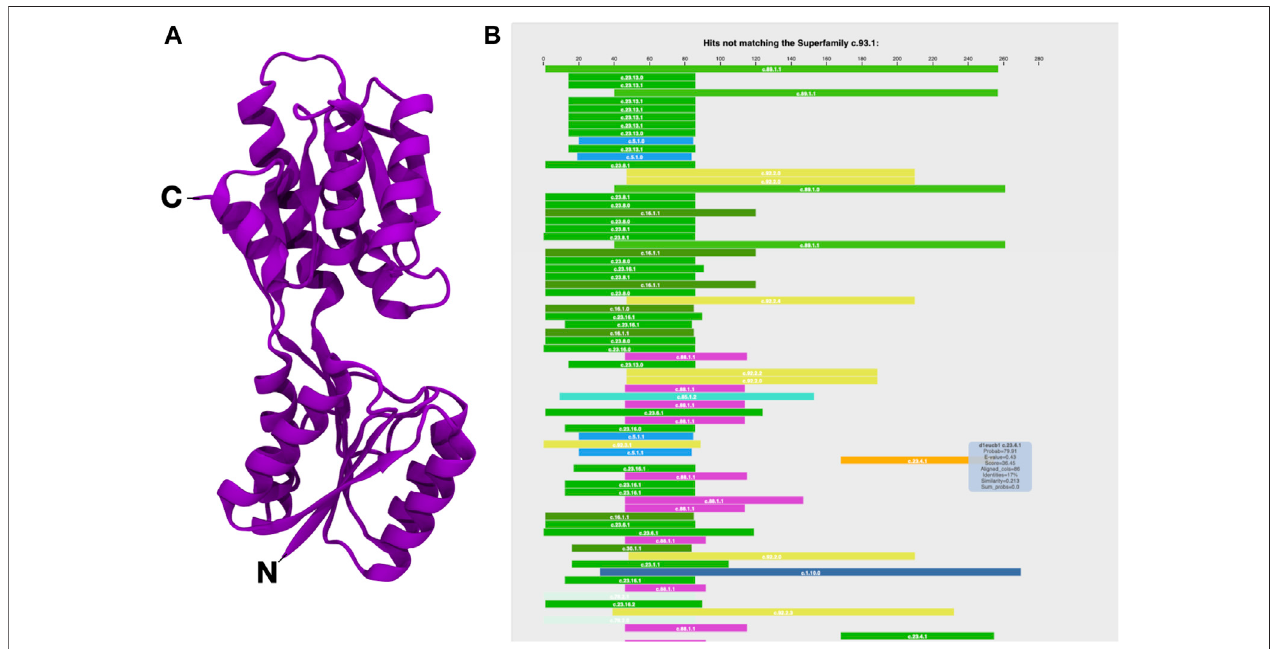
FIGURE 1 | The ribose binding protein from Thermotoga maritima (tmRBP, d2fn9a_). (A) Structure (PDB 2FN9) and (B) HHsearch overview (https://fuzzle.uni- bayreuth.de/2.0/hh/hhs-raw/d2fn9a_/). The query sequence (d2fn9a_) is taken as reference for the alignment of the proteins found (residues 1 – 280). Each bar represents a hit that is related with the query domain but does not belong to the same superfamily. The position of the bar matches the location of the hit related to the query ’ s sequence. Colors differentiate superfamilies. Extra information on the hits can be found by mousing over. Note that in this summary diagram hits that were found to other proteins of the same superfamily are not